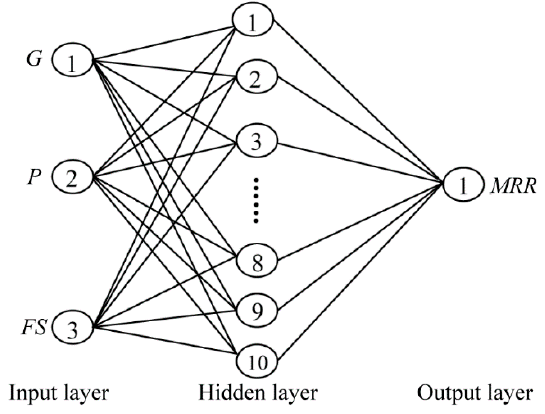
Figure 1. Structure of the BPANN obtained (3 × 10 × 1).